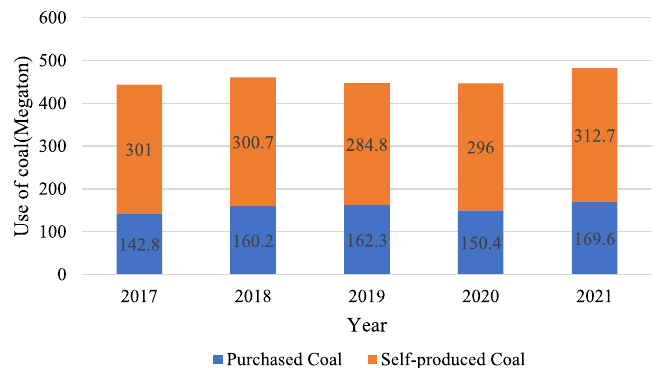
Figure 3. The amount of coal used by a coal-electricity-integrated enterprise in the past 5